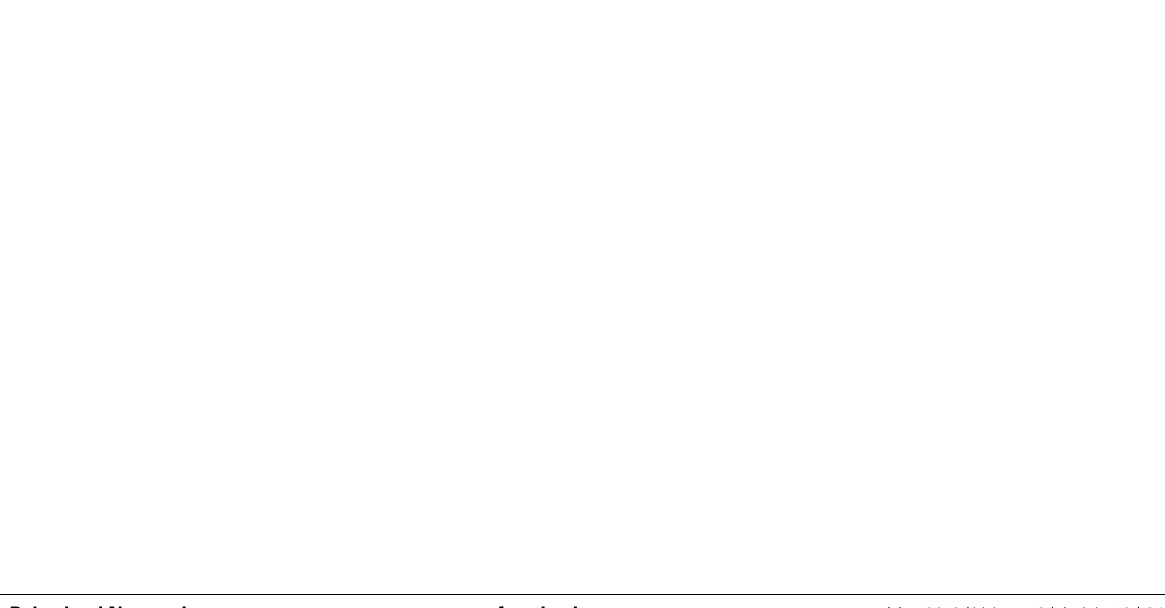
FIGUREA1 |The training setup consists of a round transparent box with central taste manifold and surrounding water spouts (upper left). Upper right shows a picture of the manifold spout with micro-well and optical